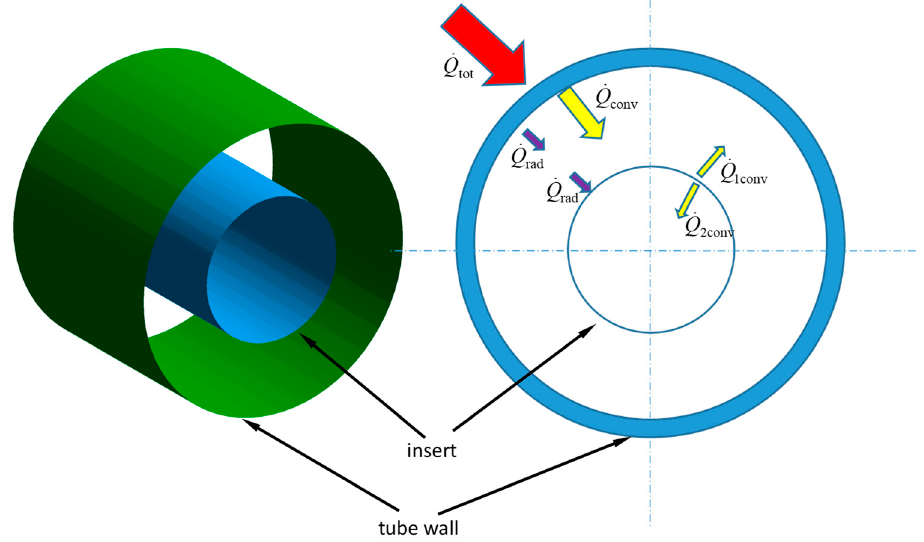
Figure 1. A fragment of a pipe with an insert and a diagram of heat fluxes.